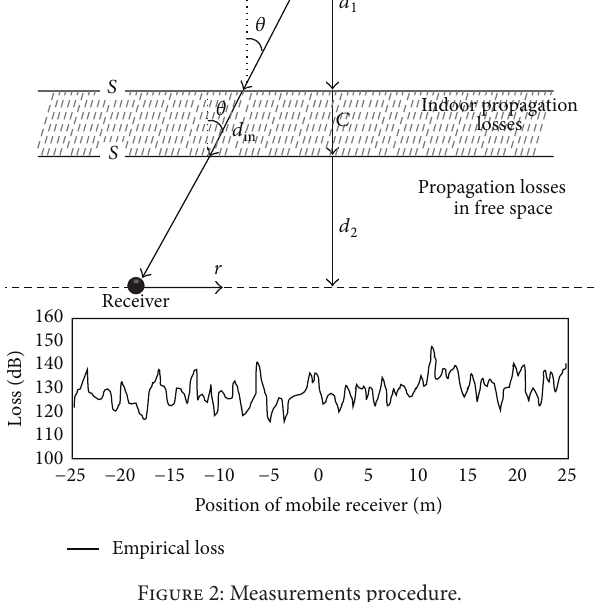
Figure 2: Measurements procedure.